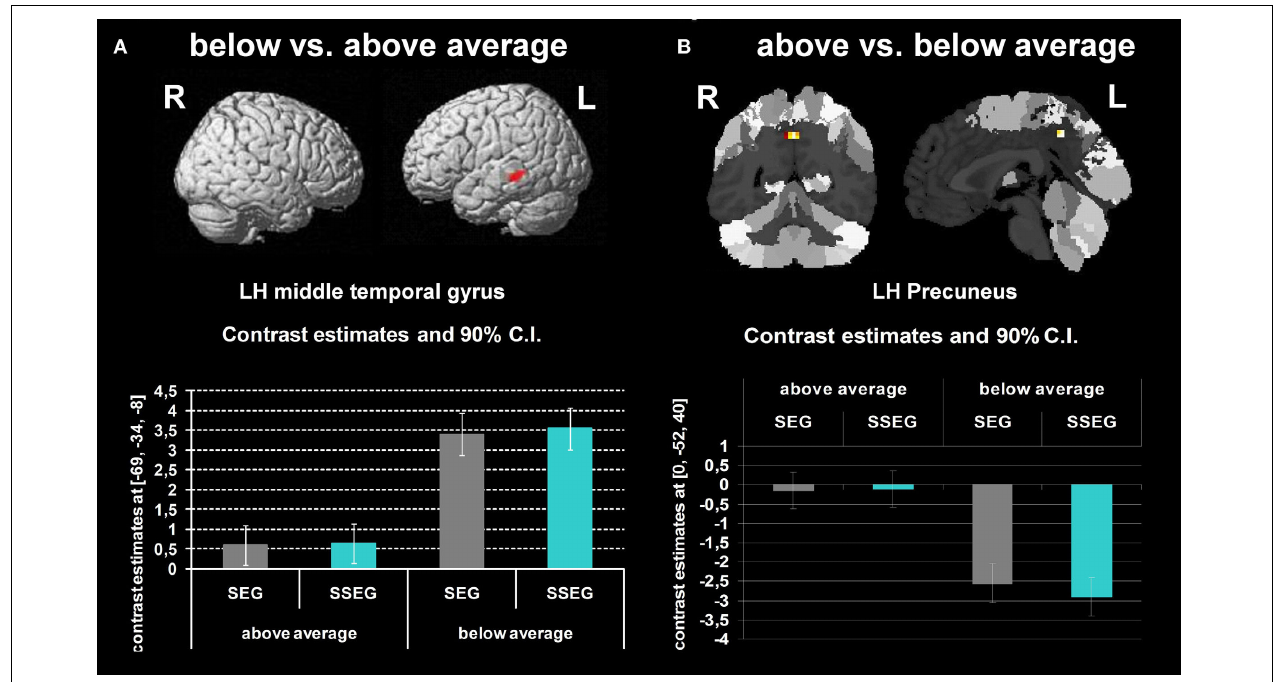
FIGURE 6 | (A) Comparison of participants below vs. above average (uncorrected p < 0 . 001, k = 10 voxels). (B) Participants above vs. below average (uncorrected p < 0 . 001, k = 10 voxels). The bar charts below the activation figure depict the corresponding beta estimates for the respective brain region.